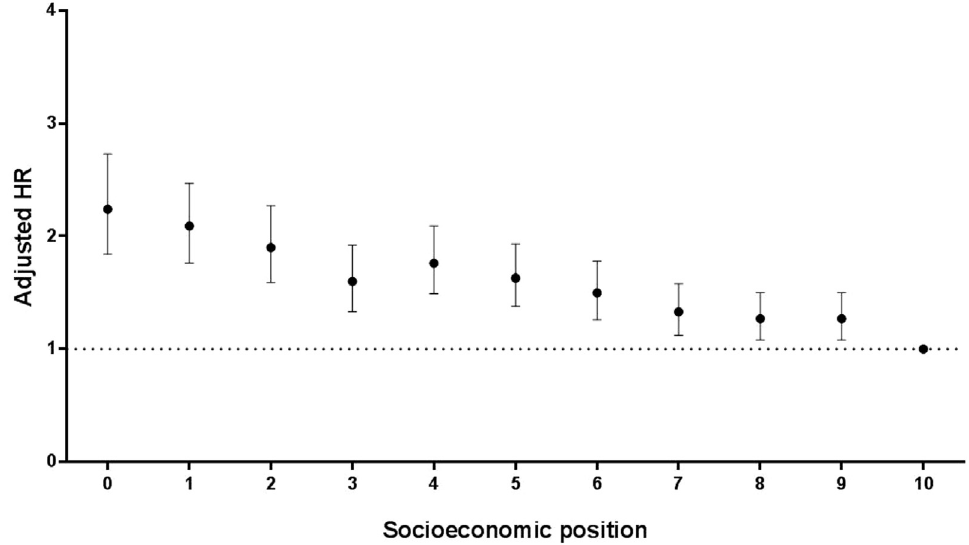
Fig. 1. Hazard ratios across socioeconomic positions (in deciles, with 0 representing Medicaid recipients). HRs adjusted for gender, age, geographical location, and disability level. HR, hazard